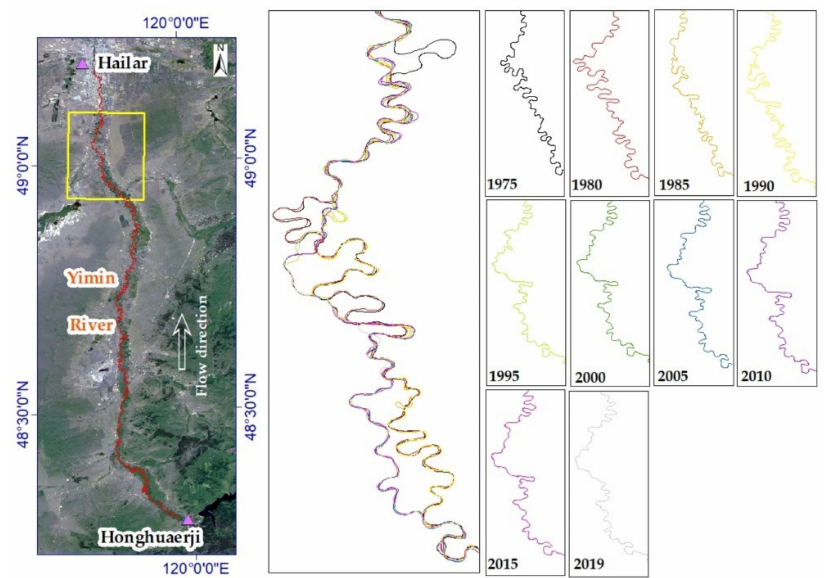
Figure 3. The extracted channel centreline in 1975, 1980, 1985, 1990, 1995, 2000, 2005, 2010, 2015, and 2019.